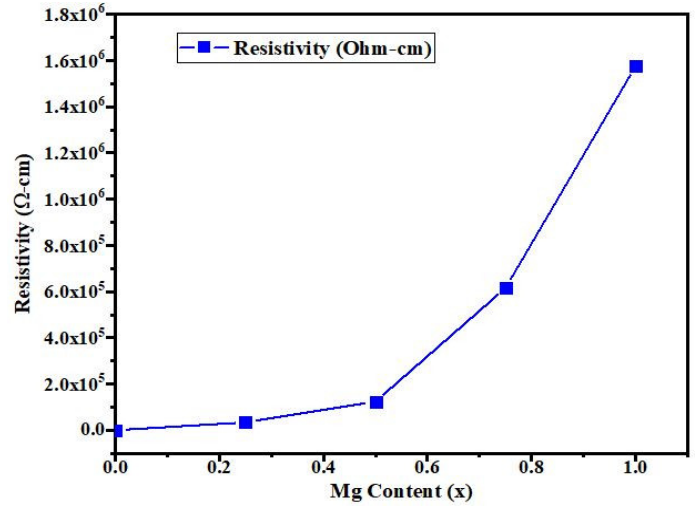
Figure 9. Electrical resistivity of CdMgO thin films with increasing Mg content.